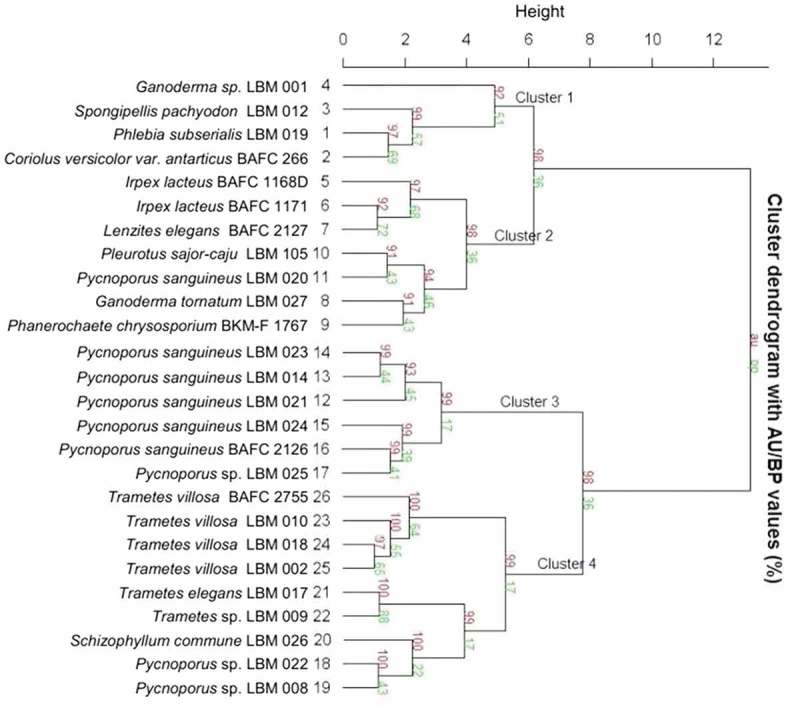
Validated dendrogram of 26 fungal isolates based on their Δτ, Lac activity and LiP activity, prepared using Infostat 2016 software linked to R software.